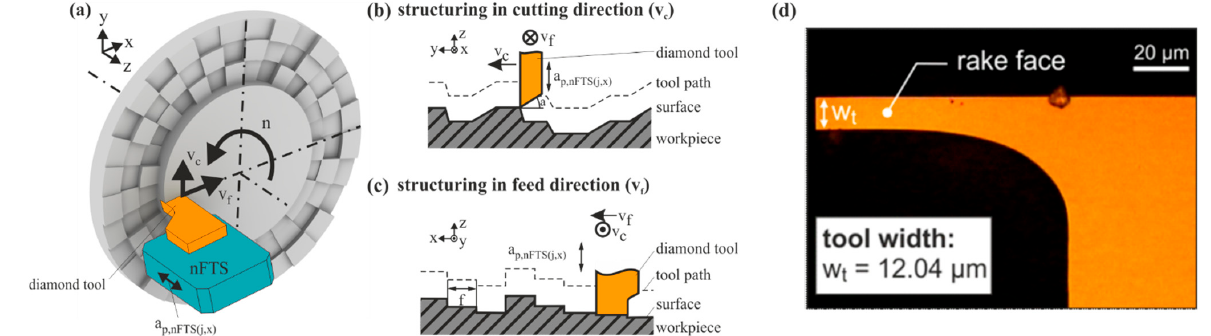
Figure 1. Process principle of diamond machining of diffractive structured surfaces. ( a ) Workpiece and nFTS with diamond tool, ( b ) structuring tool path in cutting direction, ( c ) structuring tool path in feed direction, ( d ) rectangular shaped diamond tools with a tool width of 12.04 μ m. Table 1. Process parameters for the machining of diffractive structured surfaces by diamond turning with nFTS and tool configuration.